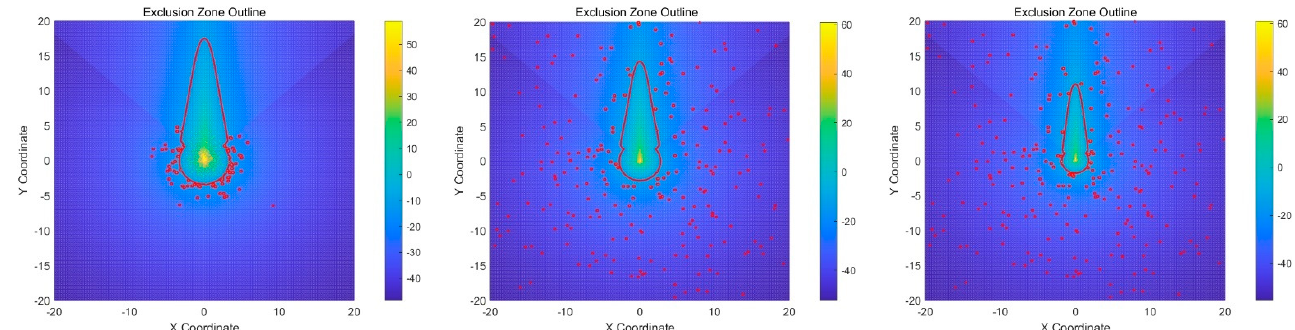
Figure 17. RMa, UMa, and UMi scenarios with an ES antenna elevation angle of 5° for the conventional omnidirectional antenna.